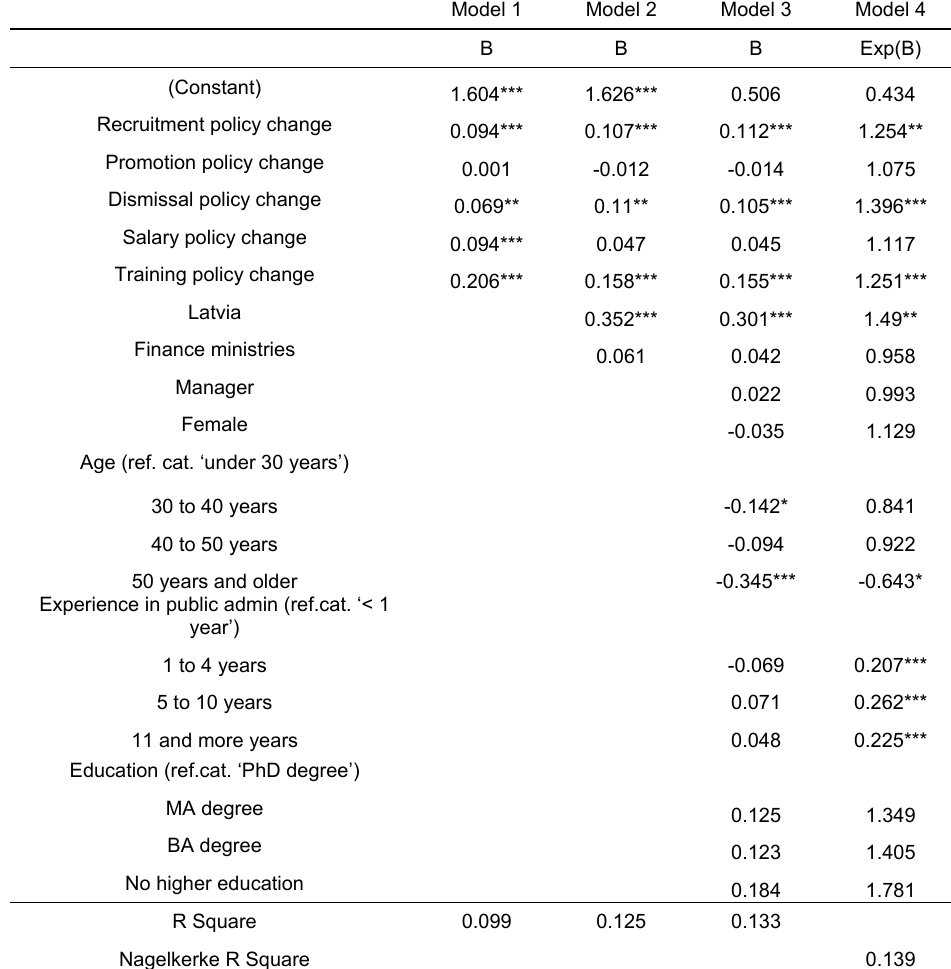
Table 2. Change of motivation since the beginning of the global economic crisis Model 1 Model